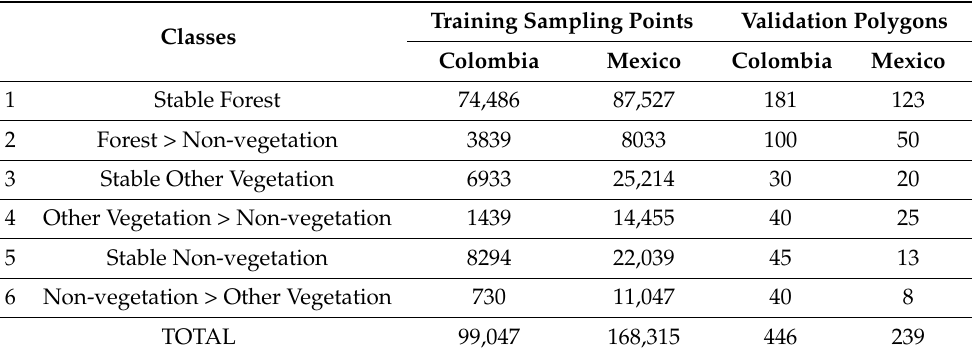
Table 2. The training and validation samples per class in each window area (Colombia and Mexico). The training points are pixel-based, while the validation areas correspond to polygons drawn by visual interpretation using PlanetScope